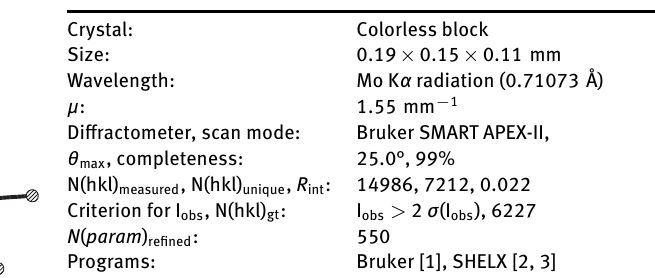
Table 1: Data collection and handling.